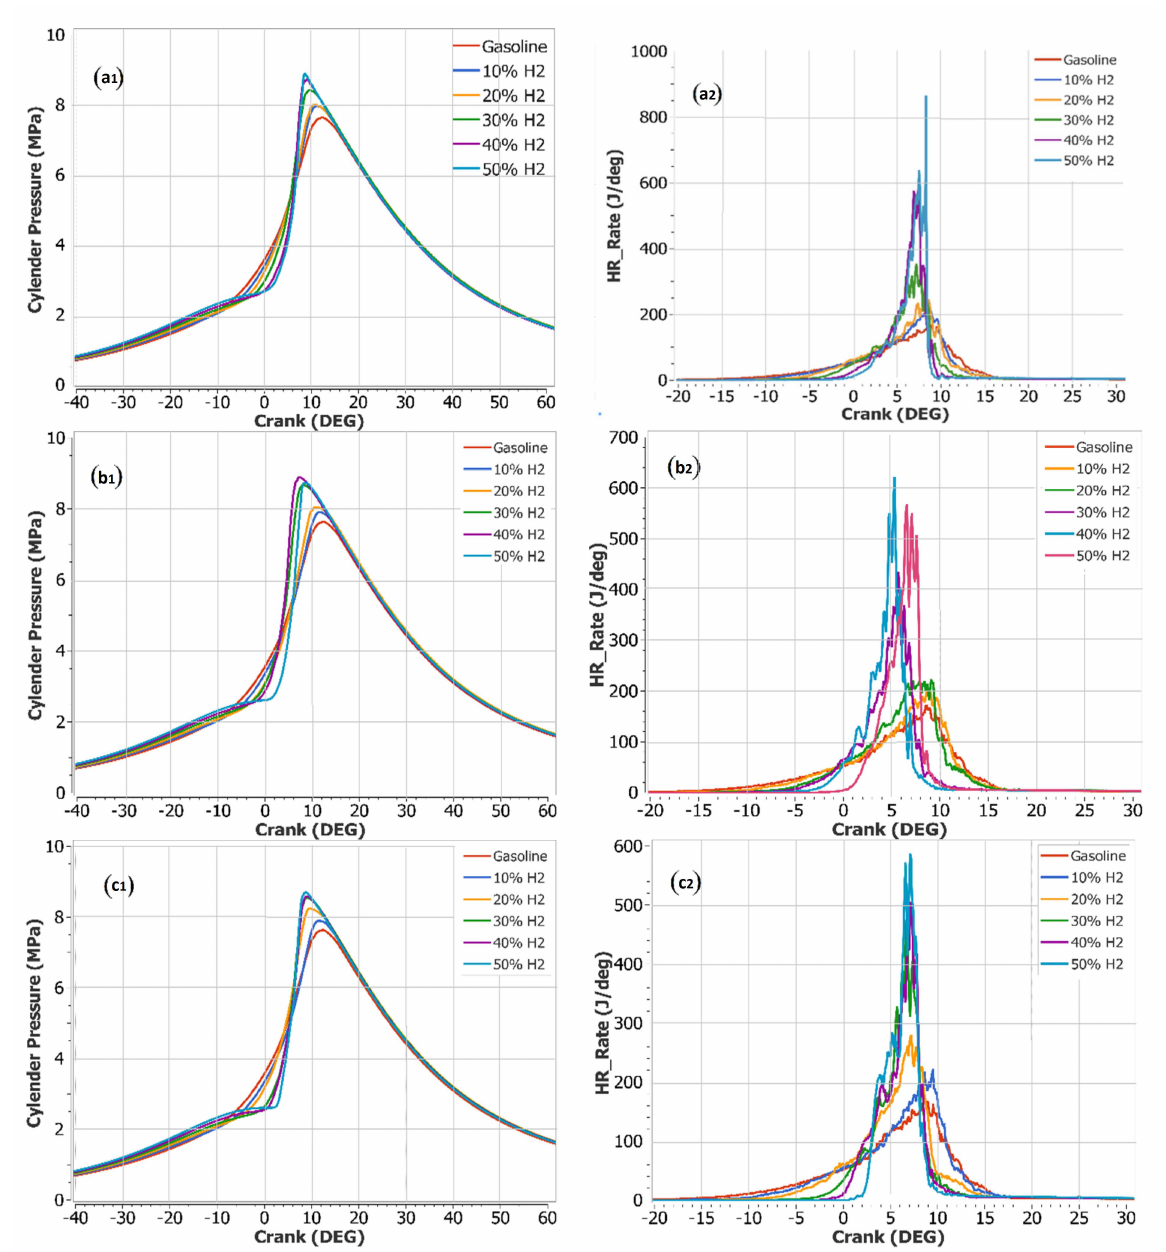
Figure 3. Effects of direct hydrogen injection timing and hydrogen energy share (HES) on the in- cylinder pressure and HRR for SOI ( a1 , a2 ) − 120 crank angle degree after top dead center (CAD aTDC) ( b1 , b2 ) − 130 CAD aTDC ( c1 , c2 ) − 140 CAD